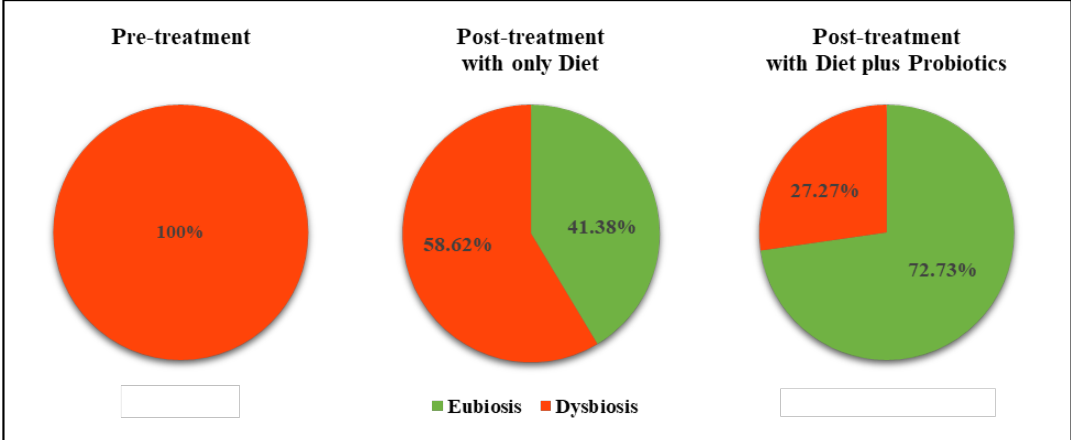
Figure 6. Pre- and post-treatment percentage distribution of eubiosis or dysbiosis condition, stratified for type of treatment (low-Ni diet alone or combined with probiotics).